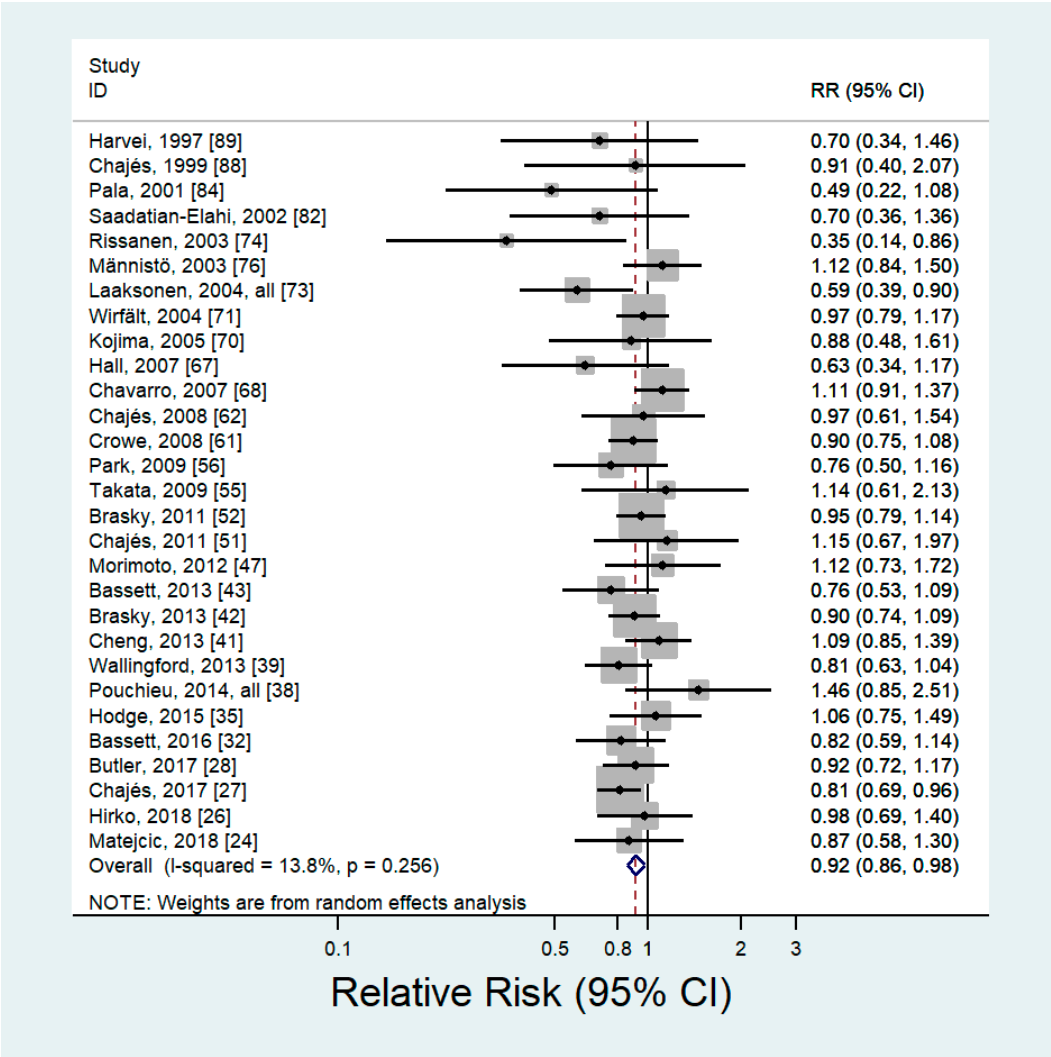
Figure 2. Forest plot of prospective studies of cancer for the highest versus lowest category of blood levels of n-6 PUFAs, using a random-e ff ects model.